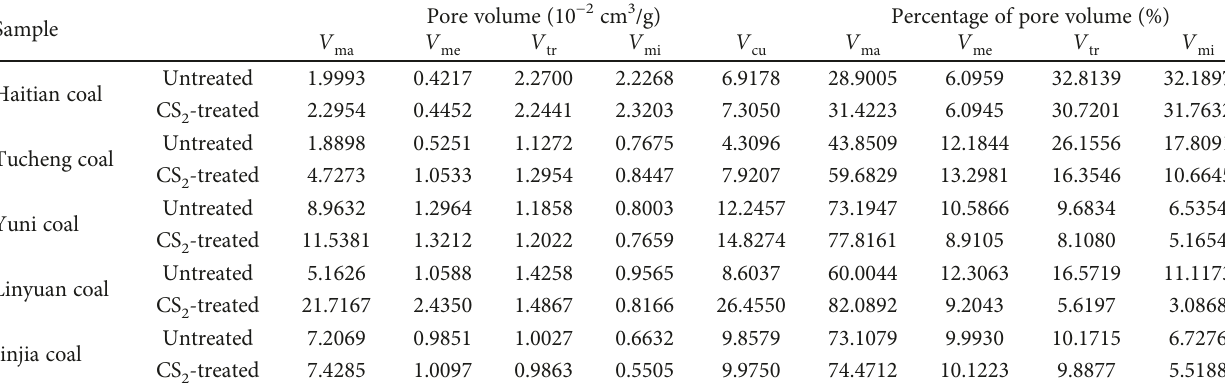
-treated coals. 2